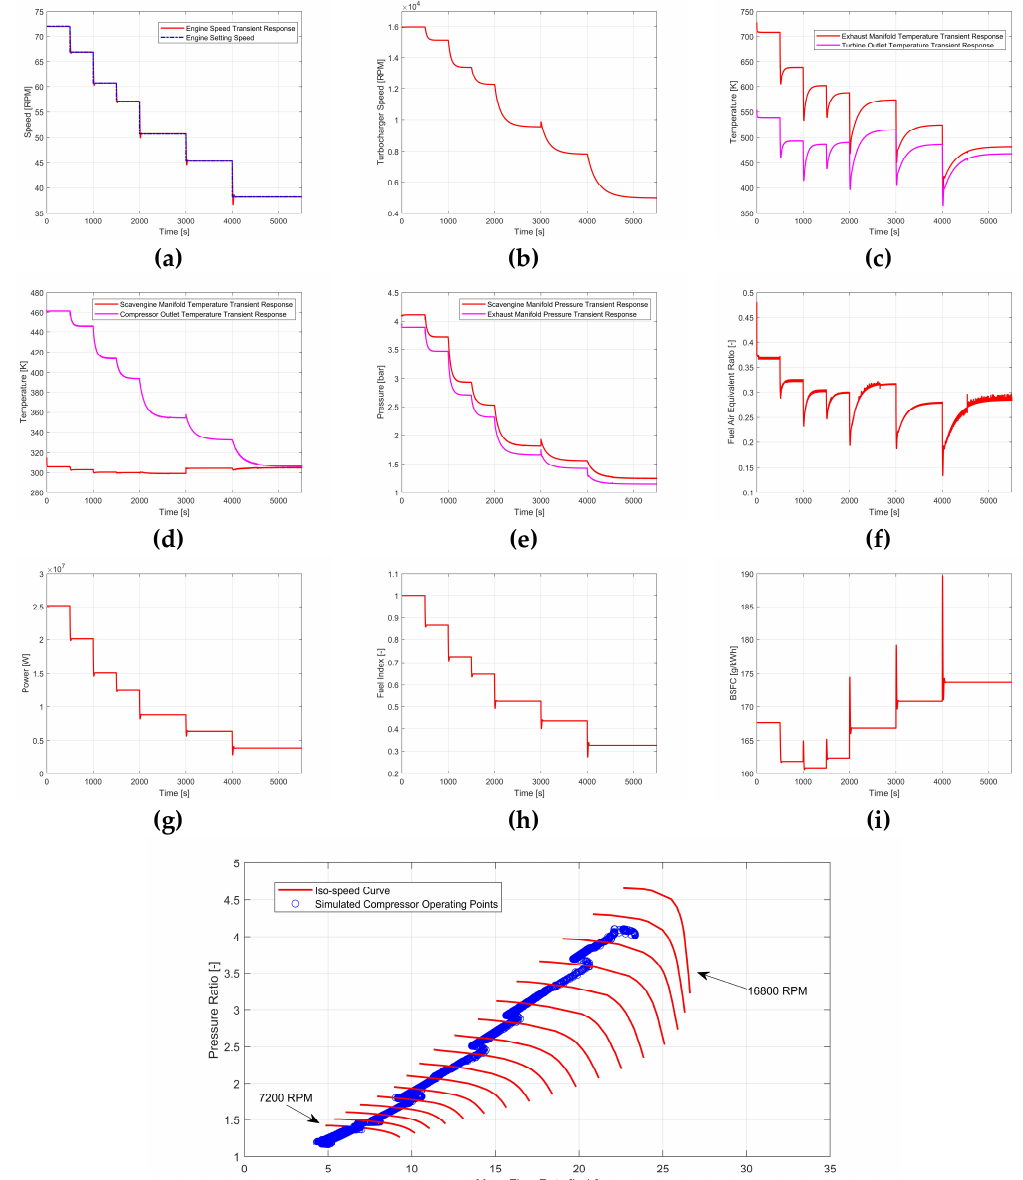
Figure 12. Simulation results for the engine transient operation with setting speed changes: ( a ) engine rotational speed; ( b ) turbocharger rotational speed; ( c ) exhaust manifold and turbine outlet temperature; ( d ) scavenging manifold and compressor outlet temperature; ( e ) scavenging and exhaust manifold pressure; ( f ) fuel-air equivalence ratio; ( g ) brake power; ( h ) fuel index; ( i ) BSFC; ( j ) compressor operating points trajectory.